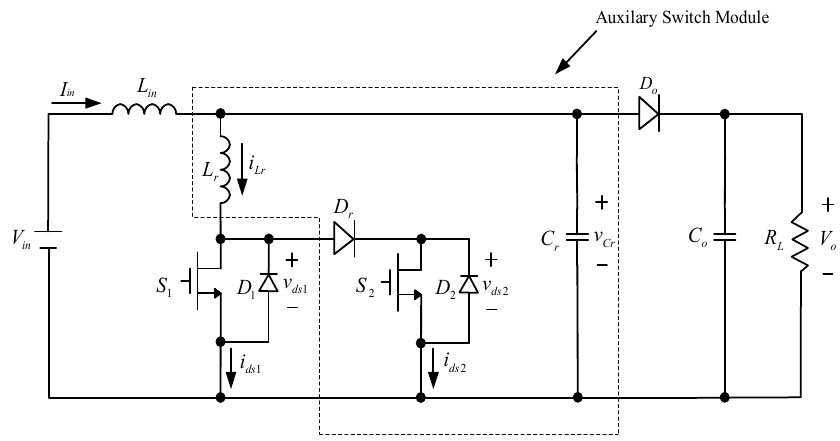
Figure 1. Proposed soft switching boost converter.